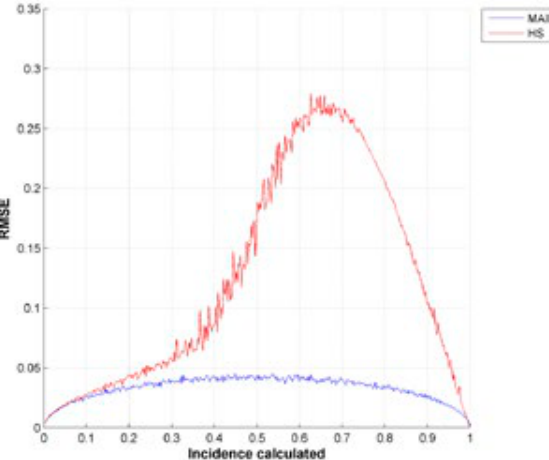
Figure 7. The Root Mean Square Error chart obtained from the average differences between the Citrus tristeza virus (CTV) calculated incidence (x100) and the CTV observed incidence, evaluated by applying each sampling